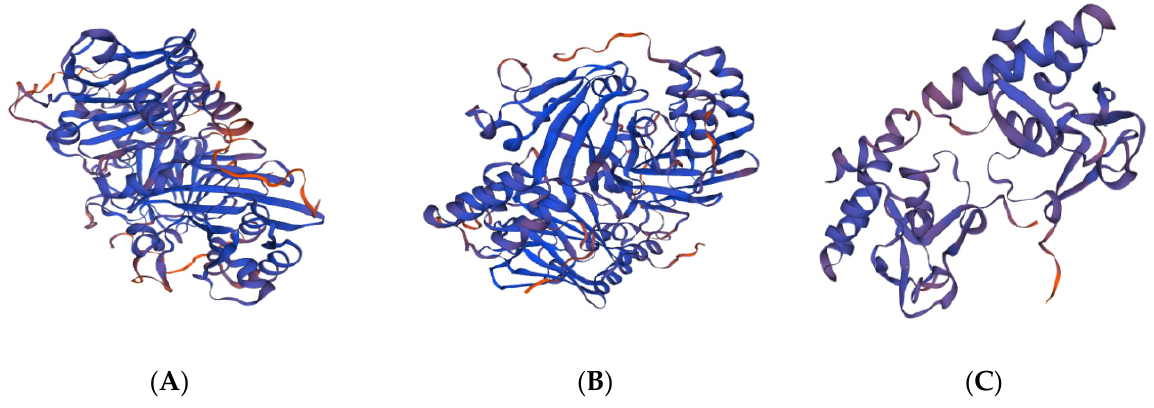
Figure 4. Protein tertiary structure of SMAD1 ( A ), SMAD2 ( B ) and SMAD3 ( C ) in Tibetan sheep.